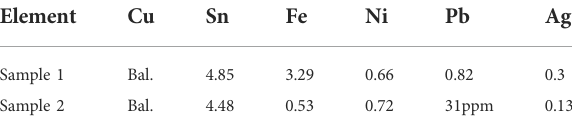
TABLE 1 Main chemical compositions of the two alloy specimens (wt%). Element